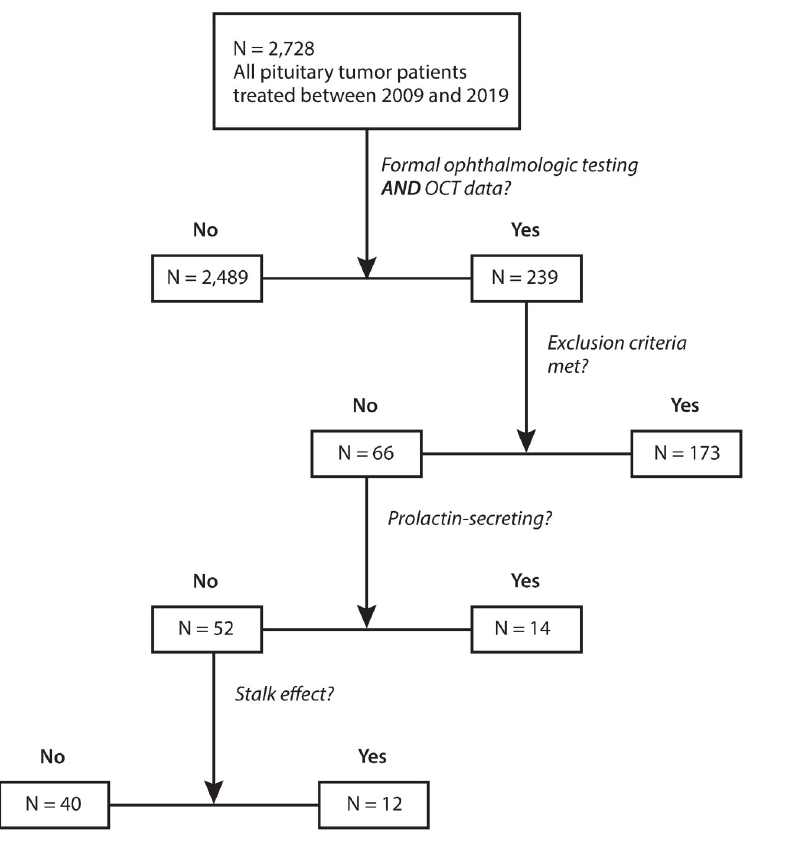
Fig 1. The patient selection flow chart. Abbreviations: OCT, optical coherence tomography.